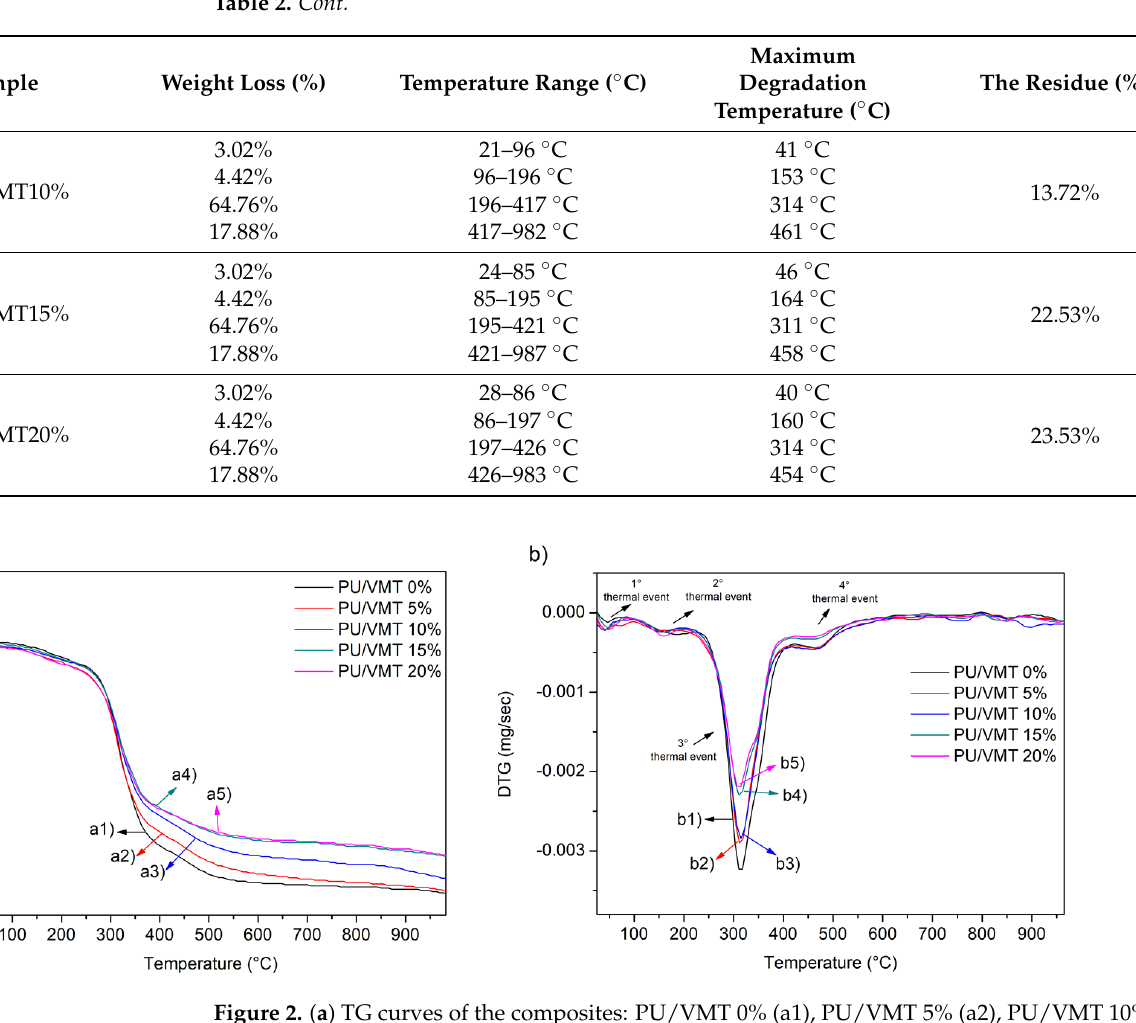
Table 2. Weight loss, temperature range, maximum degradation temperature, and residue of sam- ples.